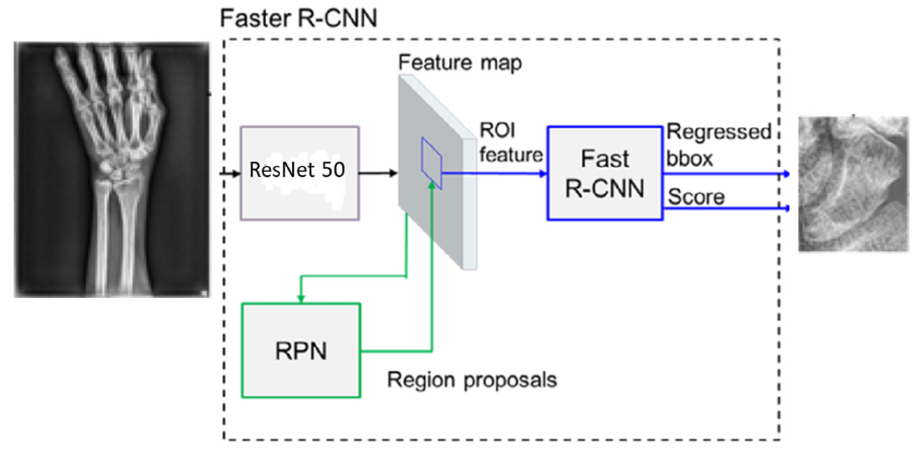
Figure 3. The structure of the Faster R-CNN model.